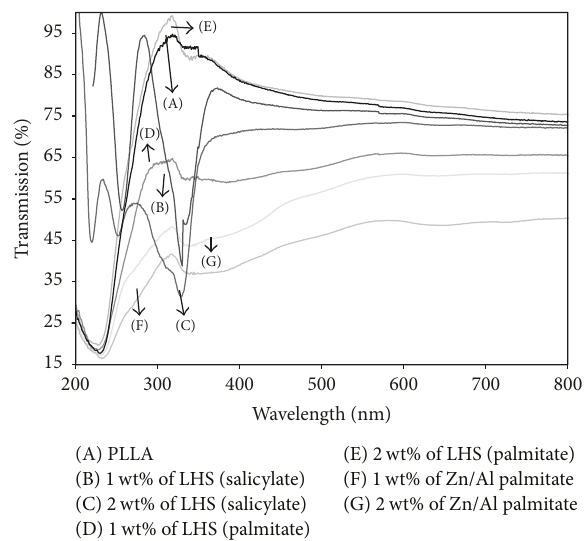
Figure 7: Percent transmission versus wavelength of PLLA (A) and PLLA nanocomposites